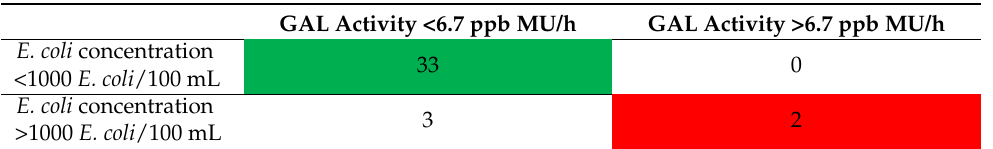
Table 1. Number of coastal bathing water samples with E. coli concentration higher or lower than 1000 E. coli /100 mL and GAL activity higher or lower than 6.7 ppb MU/h.